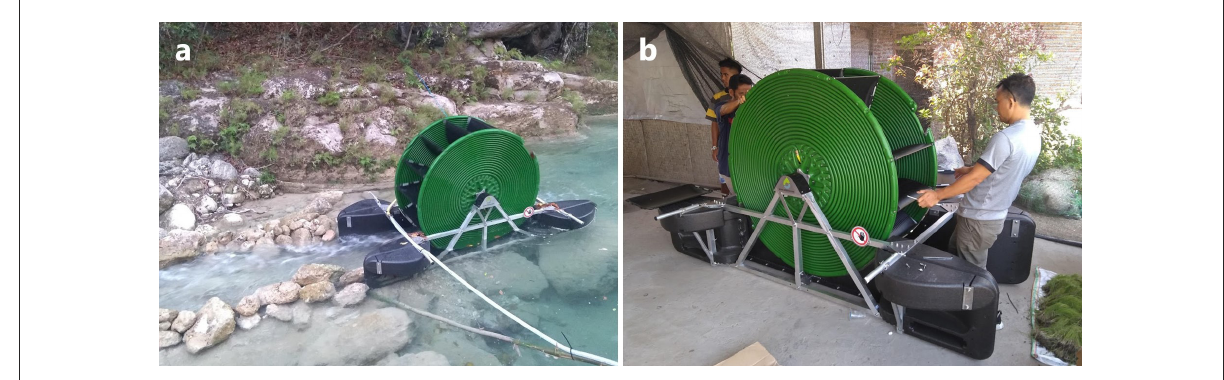
FIGURE1 The Barsha Pump. (a) Commissioned and operating in the Mbatakapidu River, Eastern Sumba. (b) Assembly before its installation.